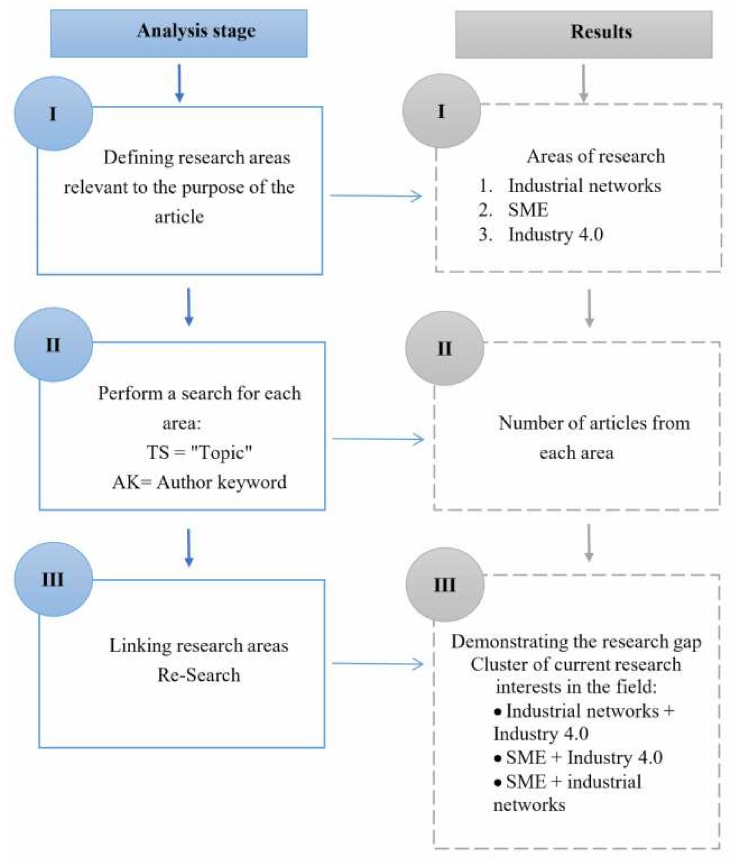
Figure 2. Search stages with results. Source: own